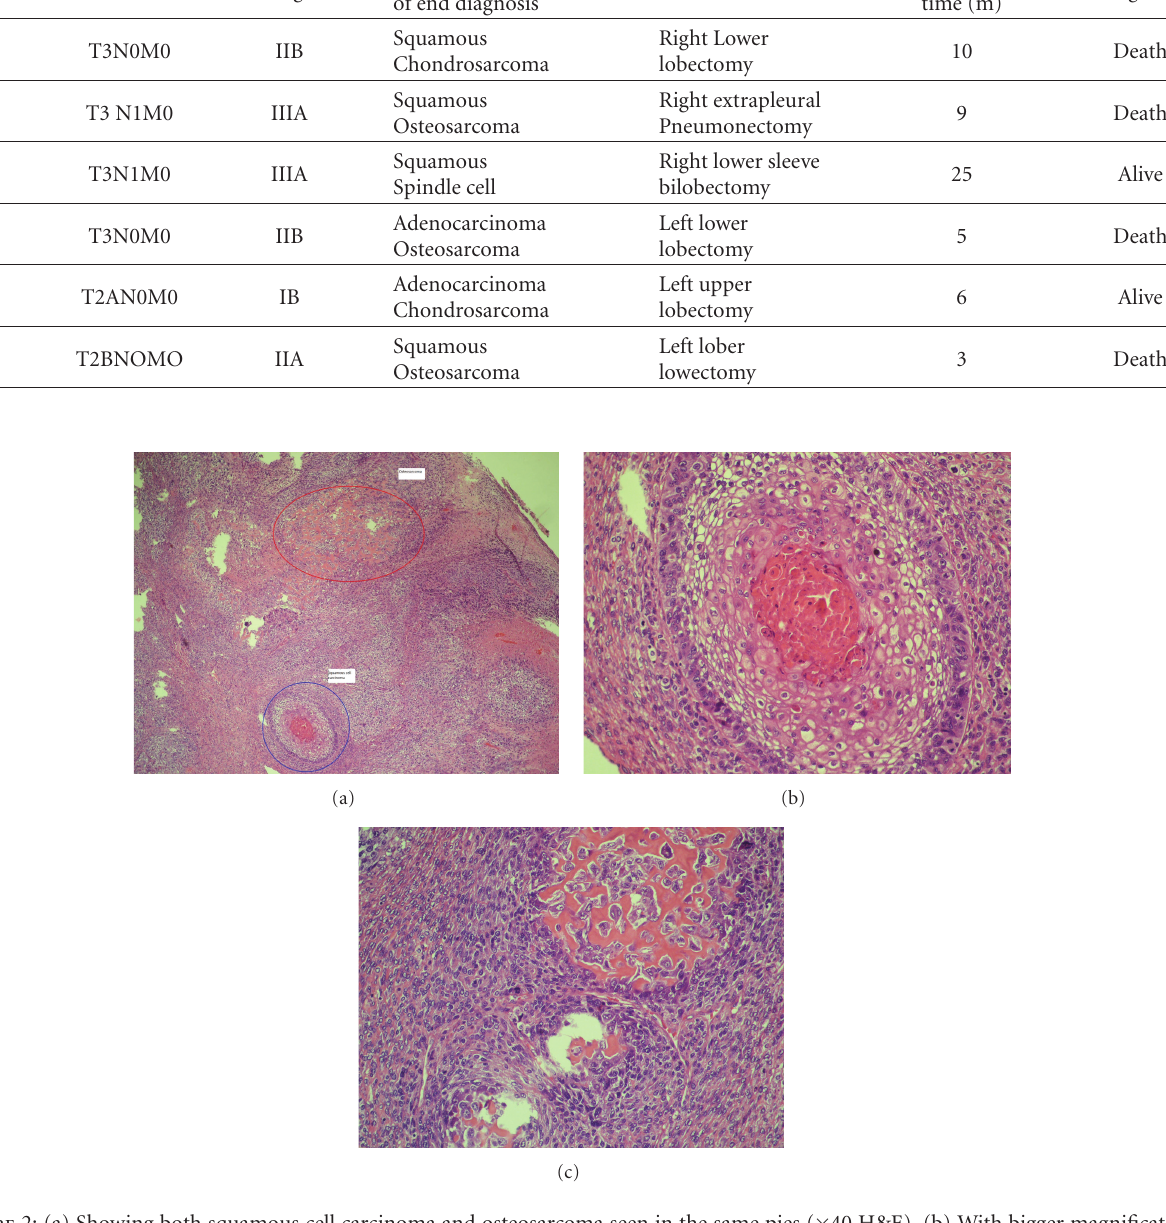
Figure 2: (a) Showing both squamous cell carcinoma and osteosarcoma seen in the same pies ( × 40 H&E). (b) With bigger magnification squamous cell carcinoma ( × 400 H&E). (c) Osteosarcoma components from the same pies ( × 400 H&E).